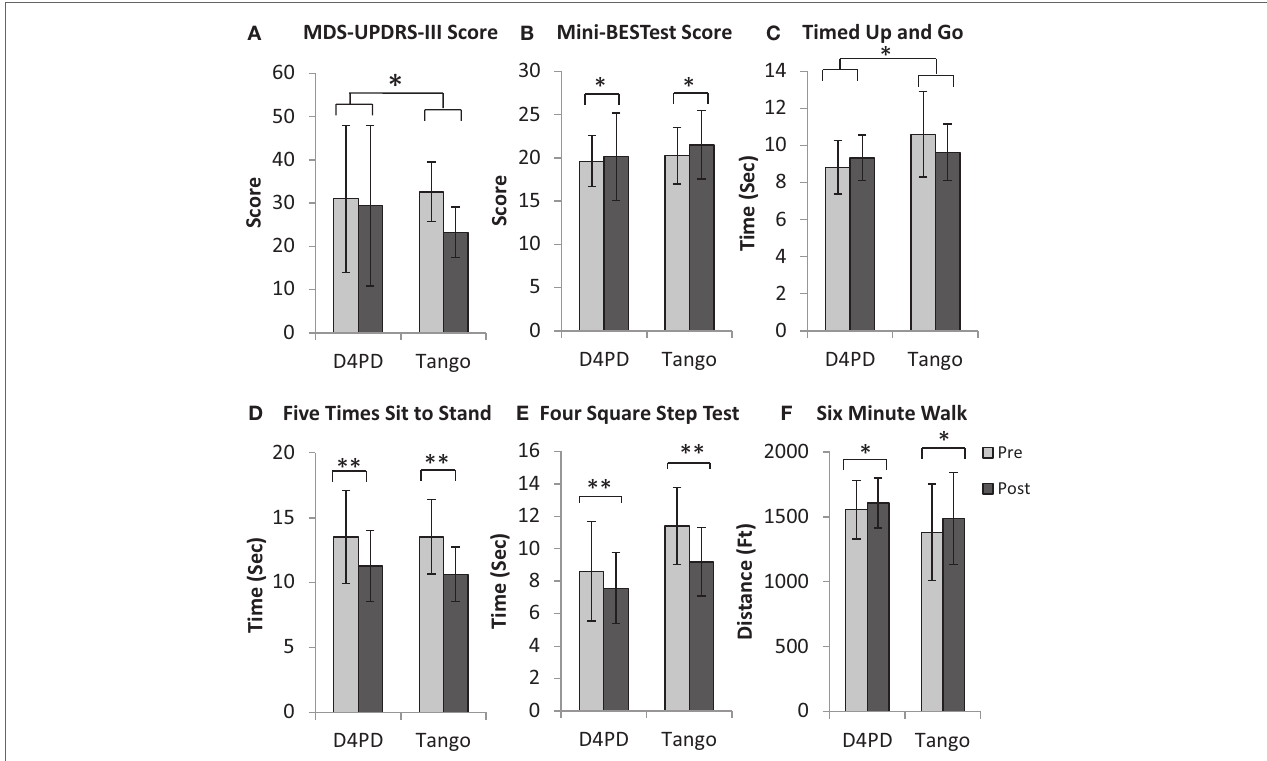
FigUre 1 | Movement disorders society unified Parkinson disease rating scale motor subsection [MDs-UPDrs-iii, (a)], mini-balance evaluation systems test [Mini-BesTest, (B)], timed up and go (c), five times sit to stand (D), four square step test (e), and 6-min walk (F) for participants in the Dance for Parkinson’s (D4PD) and tango interventions . Significant group × time interaction for MDS-UPDRS-III score and timed up and go. Significant main effect of time for Mini-BESTest score, five times sit to stand, four square step test, and 6-min walk, * p ≤ 0.05, ** p ≤ 0.01. Values are M ± SD.